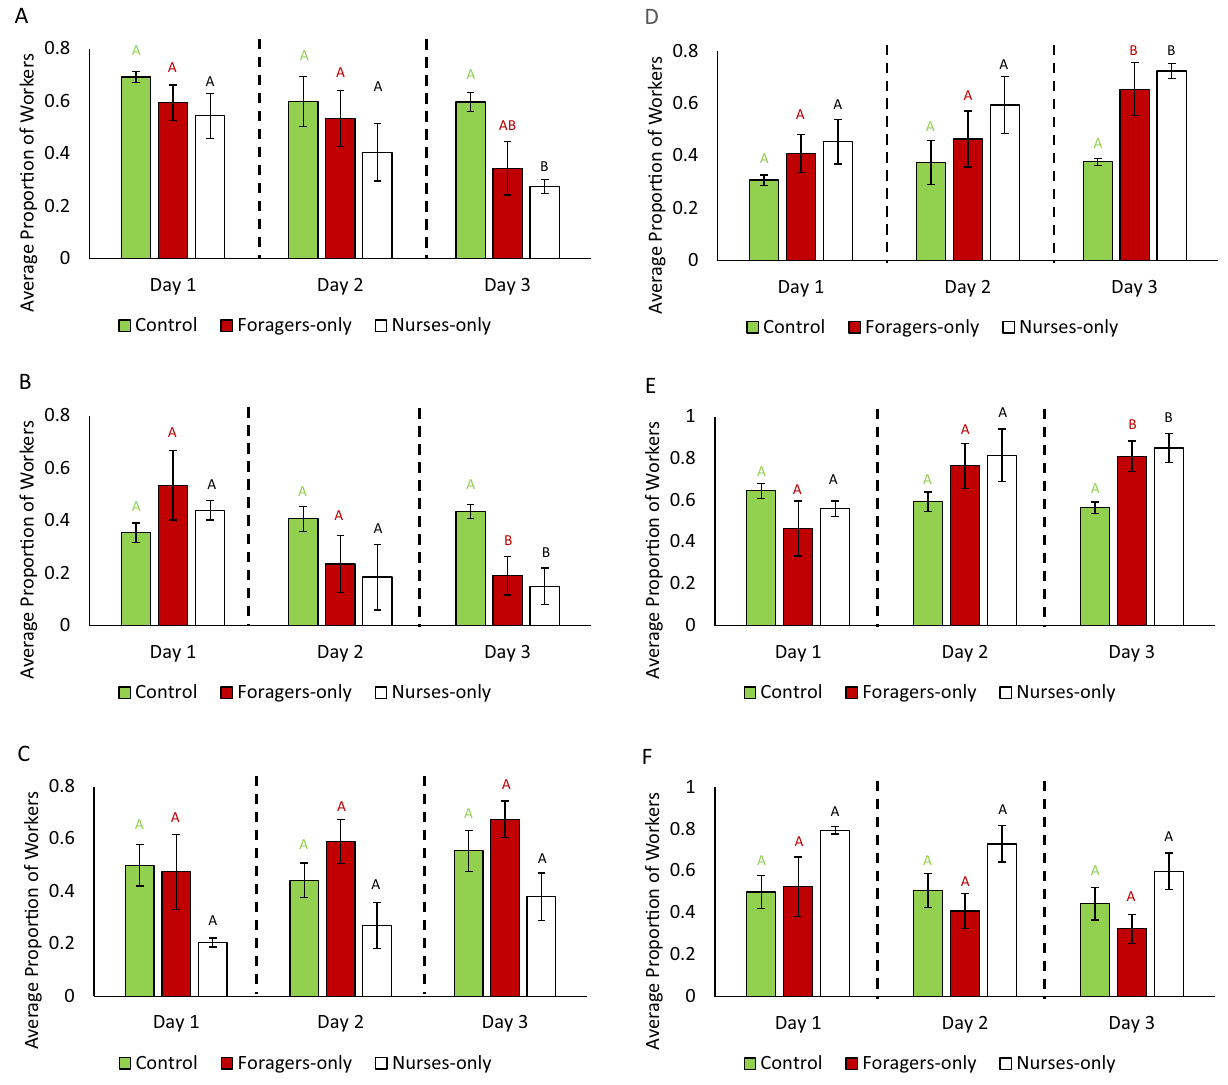
Figure 2. Task reversion analysis: average proportion (± standard error of the mean) of workers in the controls, forager-only treatments, or nurse-only treatments found performing either nursing or foraging behavior during each day of interaction with the different brood types. The proportion of workers found in the foraging arena during the 3 days while in the presence of ( A ) eggs, ( B ) larvae, and ( C ) pupae for each treatment, and the proportion of workers found in the nest during the 3 days while in the presence of ( D ) eggs, ( E ) larvae, and ( F ) pupae for each treatment. Different letters denote statistical differences ( p < 0.05). Bars represent the standard error of the